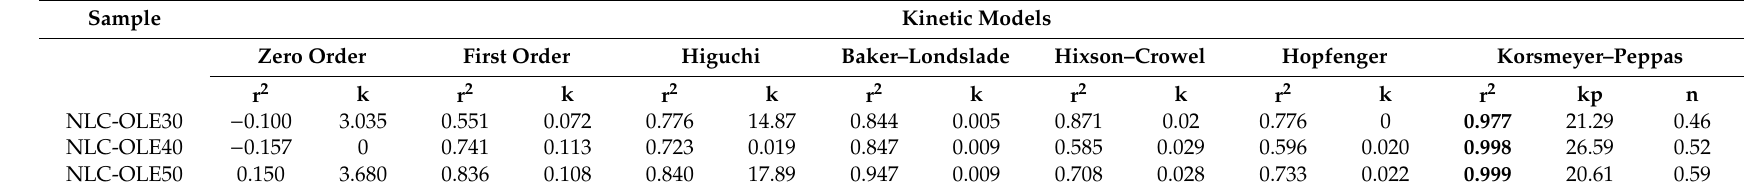
Table 2. Oleuropein (OLE) release parameters of di ff erent kinetic